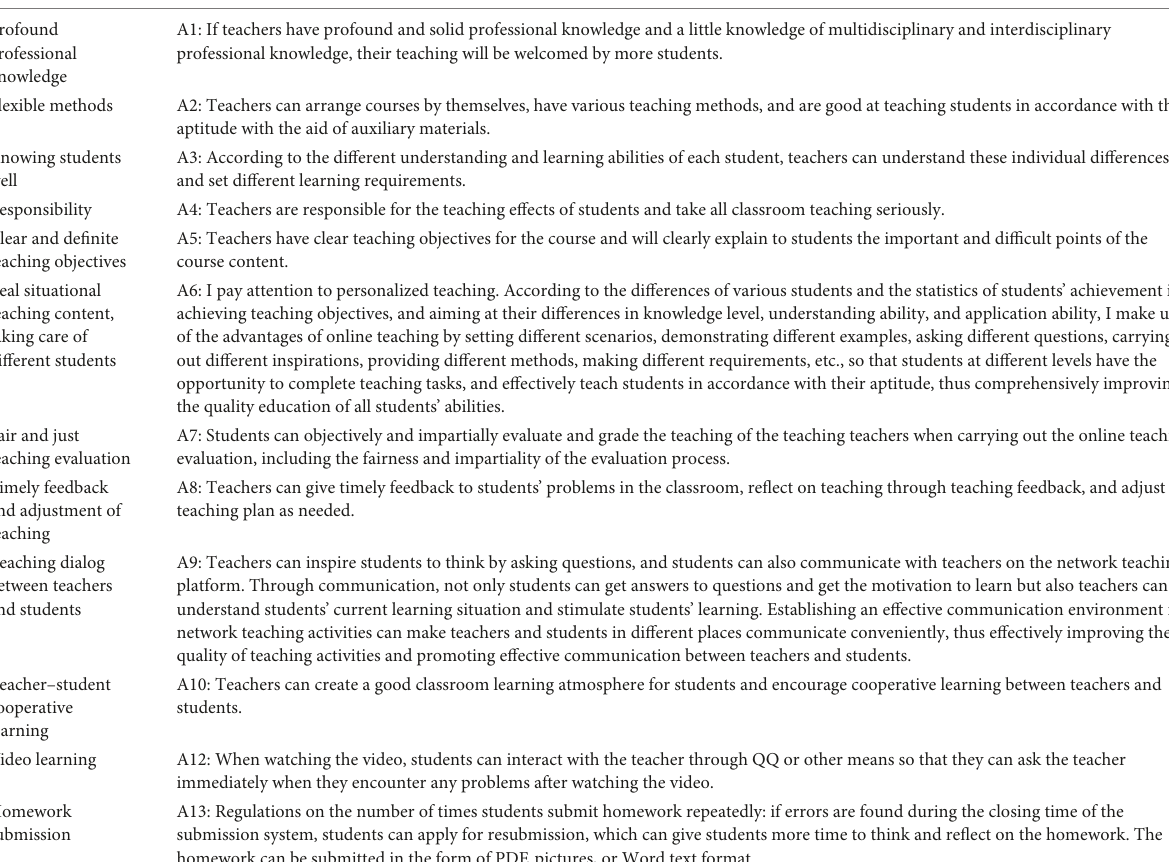
TABLE 3 Categorization of open